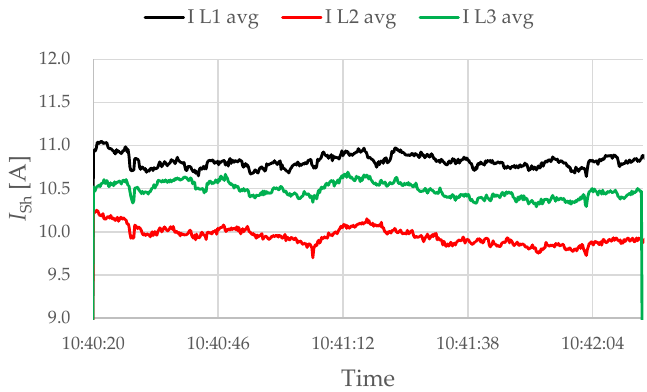
Figure 6. Cores currents measured in Substation 2. Actual operating system of sheaths (Sh1). Operation only with the analyzed line.